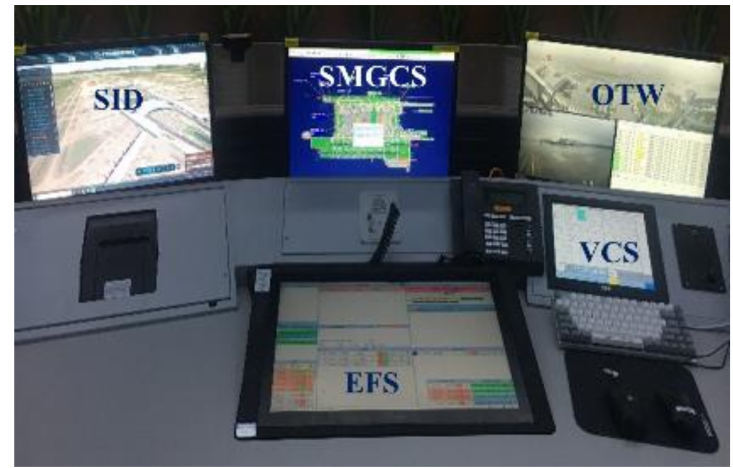
Figure 3. The layout of the digital tower module with a small LCD panoramic